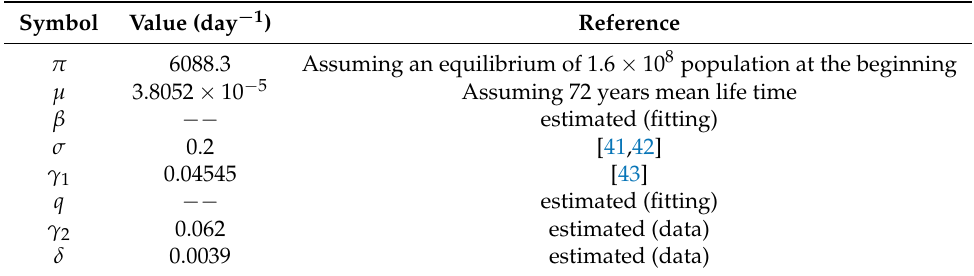
Table 2. Parameters for numerical